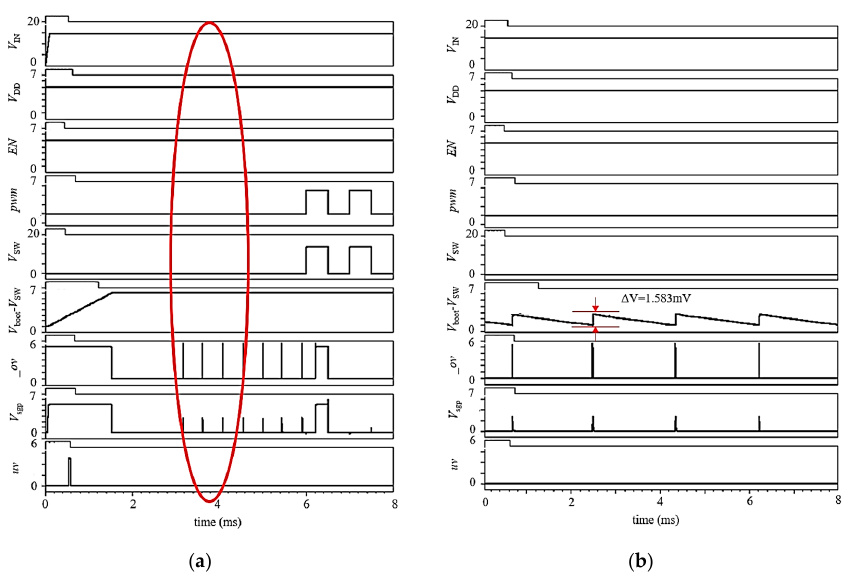
Figure 9. Simulated results of the proposed bootstrap structure: ( a ) overall result and ( b ) enlarged result.